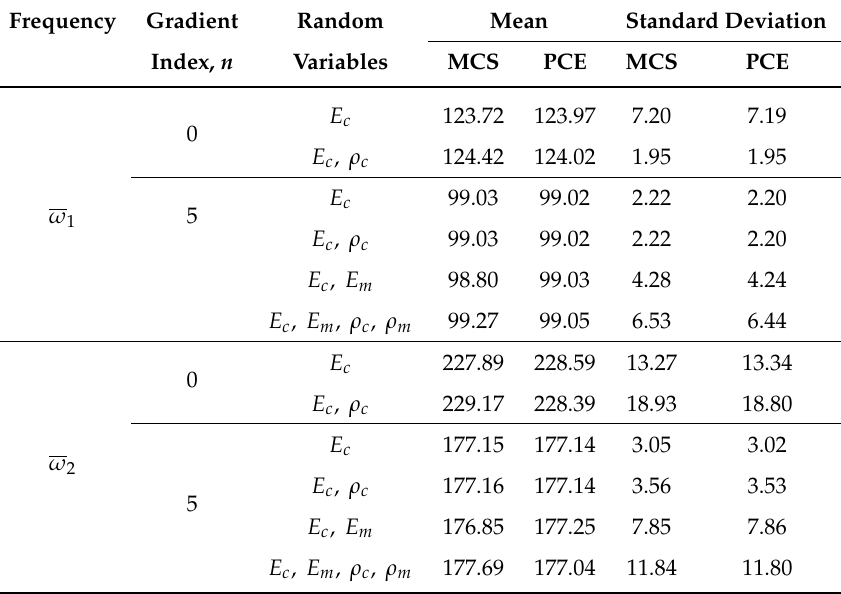
Table 6. Comparison of the mean and the standard deviation of the first two normalised natural frequencies for different cases between the MCS and the PCE. Here PCE order 1 is considered. Frequency Gradient Random Mean Standard Deviation Index,